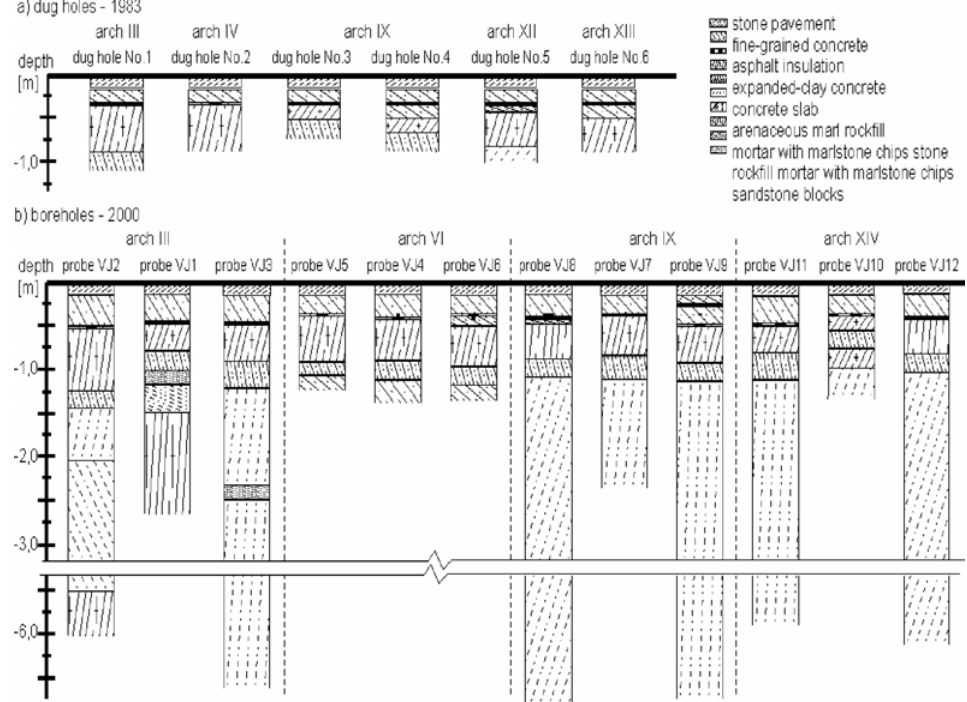
Fig 3. Composition of the bridge body filling layers as recorded in test holes and applied in the repair project of 1967–1975 (for bridge pier and bridge span numbering, Fig